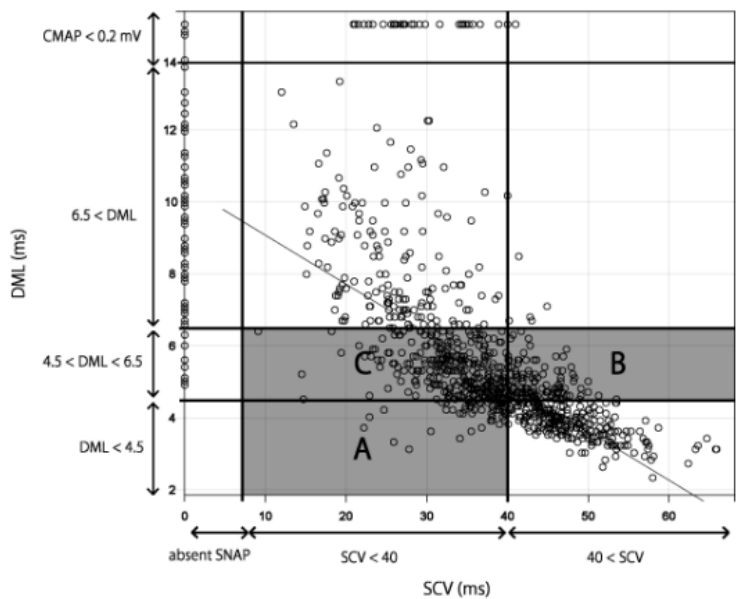
Figure 6. Analysis of the Bland classification. Area A: Grade 2 in Figure 1b. Area B: normal SCV in Grade 3 in Figure 1b. Area C: SCV < 40 m/s in Grade 3 in Figure 1b. The straight line shows the correlation between SCV and DML in Figure 2. Abbreviations: CMAP, compound muscle action potential; DML, distal motor latency; SCV, sensory nerve conduction velocity; SNAP, sensory nerve action potential.